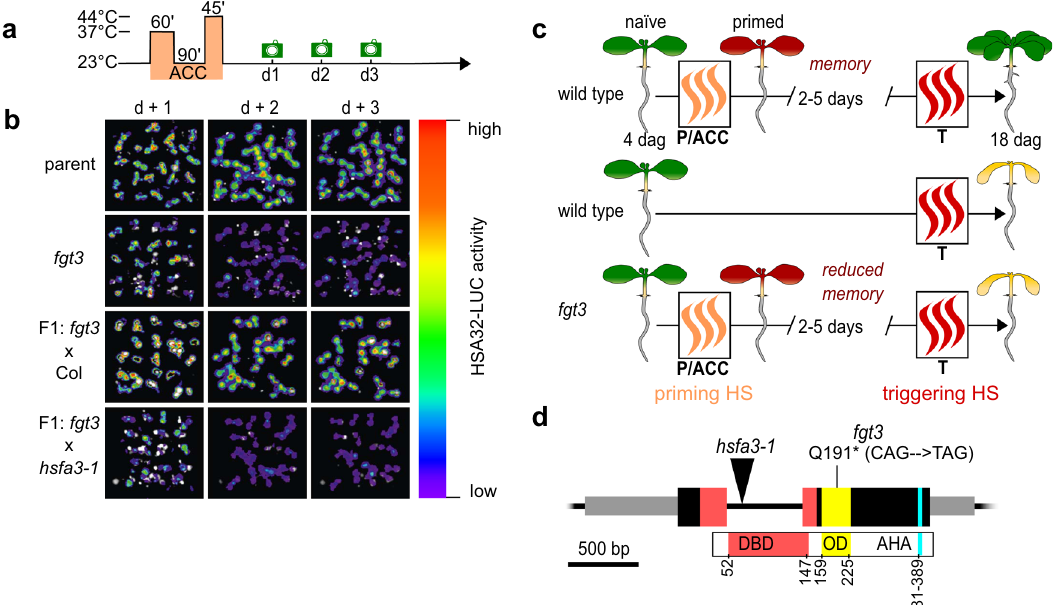
Fig. 1 FGT3 / HSFA3 is required for HS memory. a Treatment scheme for LUC-based HS memory assay: 4 d-old seedlings were exposed to a two-step acclimation treatment (ACC; 60 min 37 °C, 90 min 23 °C and 45 min 44 °C). Activity of the HS memory marker pHSA32::HSA32-LUC was scored on the following three days (green camera symbols). b LUC-based HS memory assay shows reduced maintenance of pHSA32::HSA32-LUC induction in forgetter 3 (fgt3) mutants. Crossing to Col but not to the hsfa3-1 mutant complements the defect of fgt3 in the F1 progeny. c Schematic representation of physiological HS memory: Plants that have not experienced any HS (naïve plants) can be primed by a non-lethal HS (P or ACC), leading to an enhanced capacity to withstand a triggering HS (T). This enhanced thermotolerance results in increased survival of T in a primed plant compared to a naïve plant for up to 5 d (HS memory). Fgt3 mutants are defective in HS memory and do not survive the T despite prior priming. d Schematic representation of the HSFA3 locus ( At5g03720 ) with location of the fgt3 (Q191*) and hsfa3-1 mutations. Exons are shown as large black boxes with protein domains overlaid in color (DBD: DNA-binding domain, OD: oligomerization domain, AHA: AHA motif), aa numbers are given to depict the positions of protein domains. UTRs are shown as gray boxes and the intron as a black